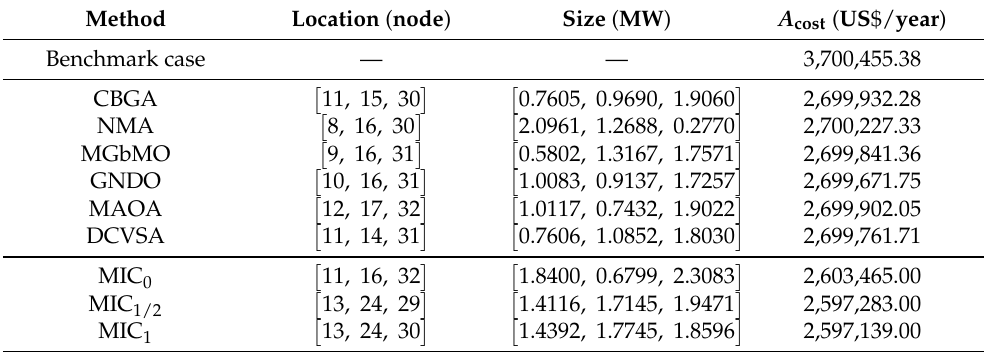
Table 4. Numerical performance of the metaheuristic optimizers and the proposed MIC model in the IEEE 33-bus